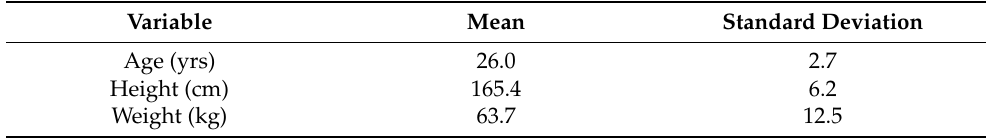
Table 1. Subject demographics